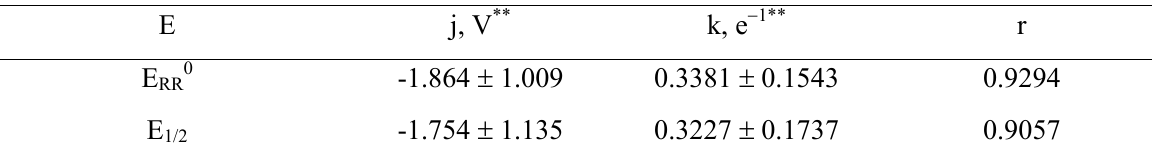
Table 1c. Correlations of standard potentials of reductive dimerization (E RR0 ), semineutralization ) ( vs saturated Hg Cl electrode) obtained on XC potentials (E 1/2 2 2 sulphite [7, 8], with A values (m = 7) * .